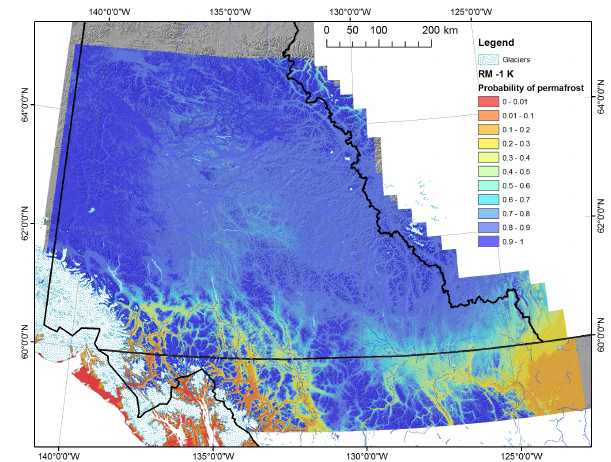
Fig. 3. Regional model permafrost probability map under a − 1 K climate change scenario, possibly corresponding to LIA conditions. Permafrost underlies 76% of the region under this scenario.